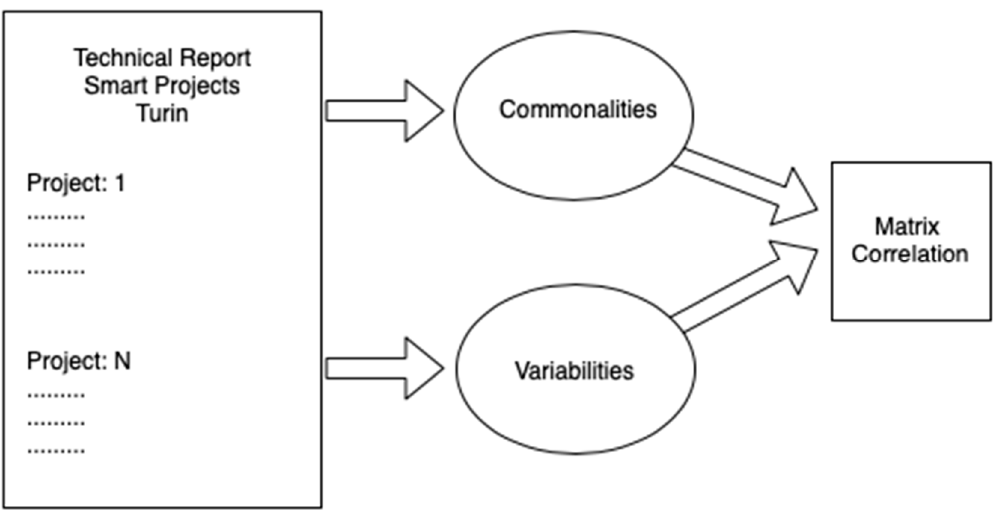
Figure 12. Commonality and variability analysis.